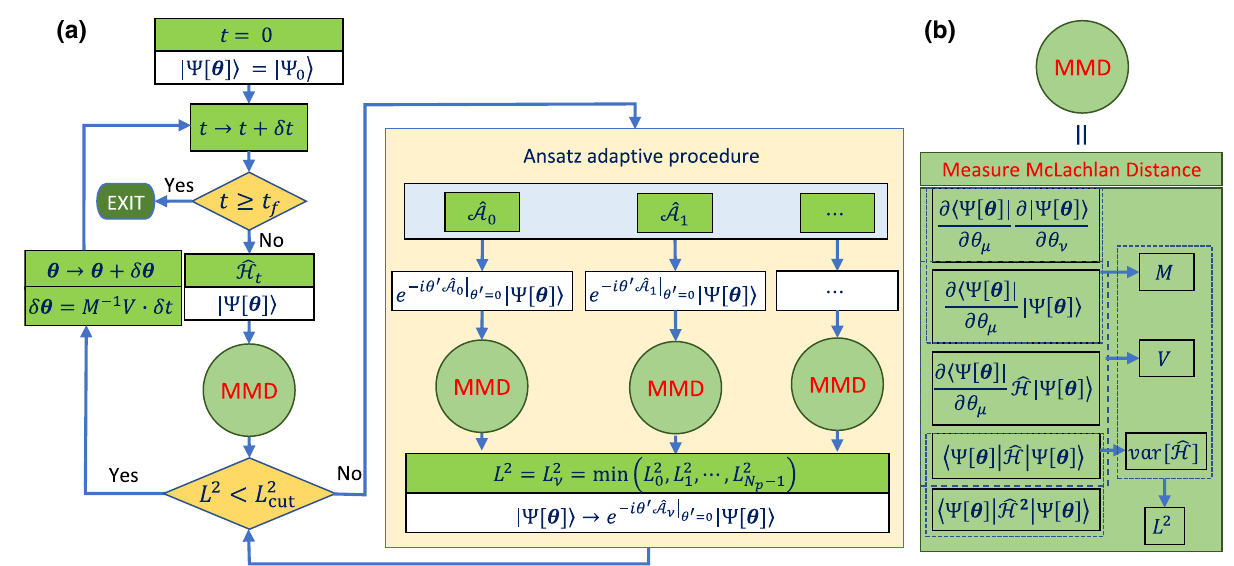
FIG. 1. Schematic illustration of the AVQDS algorithm. The flow chart of AVQDS is plotted in (a). The details of the MMD module, which measures the McLachlan distance for a given variational wave function (cid:4) [ θ ] and time-dependent Hamiltonian in (b). The circuits to measure matrix M and vector V can be found in Ref. [27] (see also Fig. 2). Note that in the ansatz adaptive procedure, one only needs to measure the incremental elements in M and V , which are added in a given